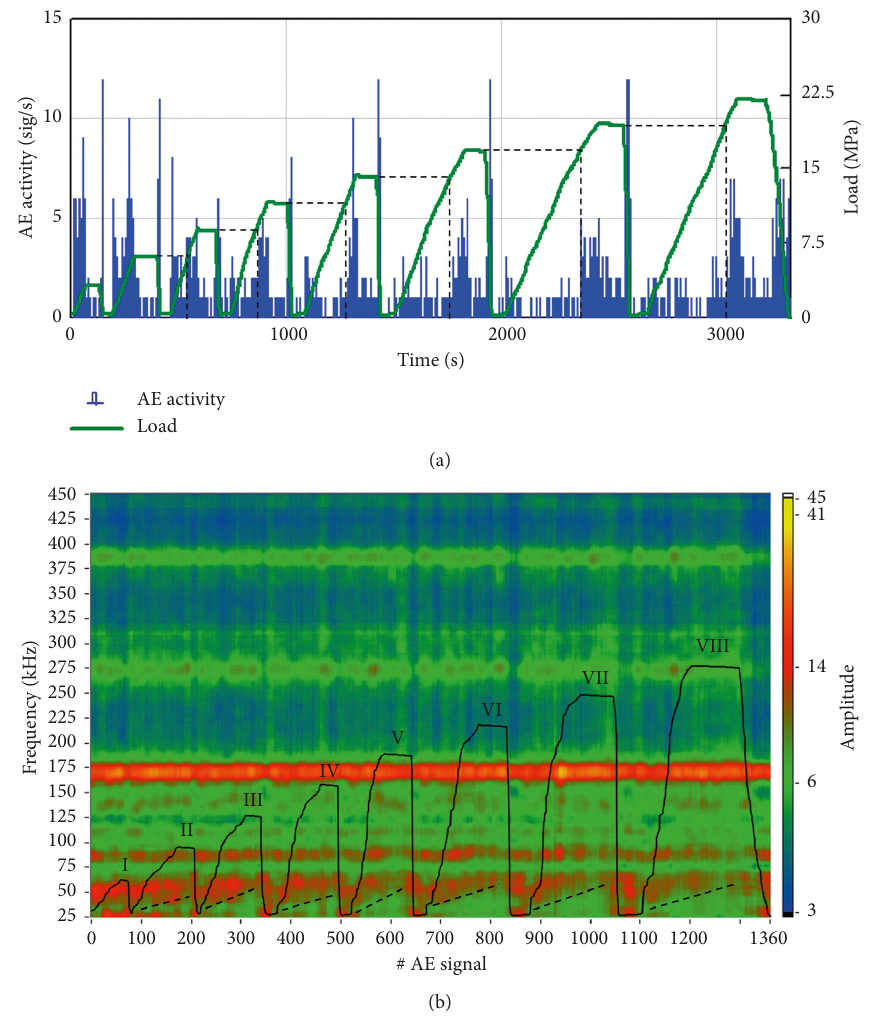
Figure 5: AE activity upon loading a sample from the first group of the “B” series (a) and an example of the obtained spectrogram with superposition of σ ( N )